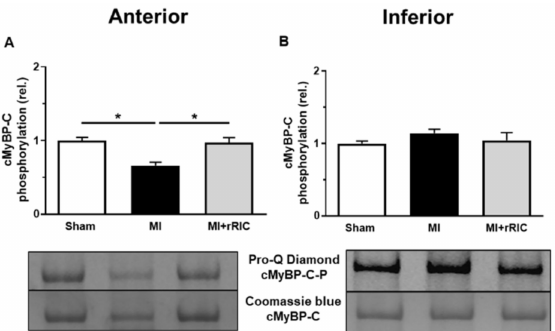
Figure 7. cMyBP-C phosphorylation in cardiomyocytes in the anterior ( A ) and inferior ( B ) LV regions. Total phosphorylation levels of cMyBP-C were investigated with Pro-Q ® Diamond phosphoprotein staining. The upper bands illustrate the phosphorylation status of cMyBP-C and the lower bands indicate the total protein amounts for each representative membrane ( n = 5–13 independent deter- minations from at least 4–5 different heart samples). Values are given as mean ± SEM, * p < 0.05 vs. control (Sham) groups.